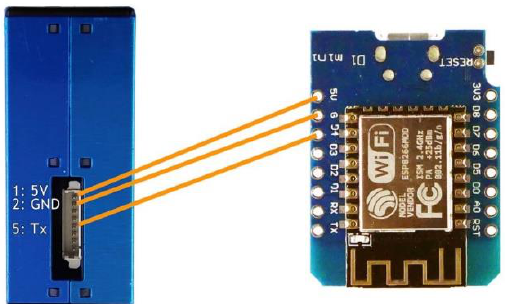
Figure 6. Assembly of the basic dust air quality